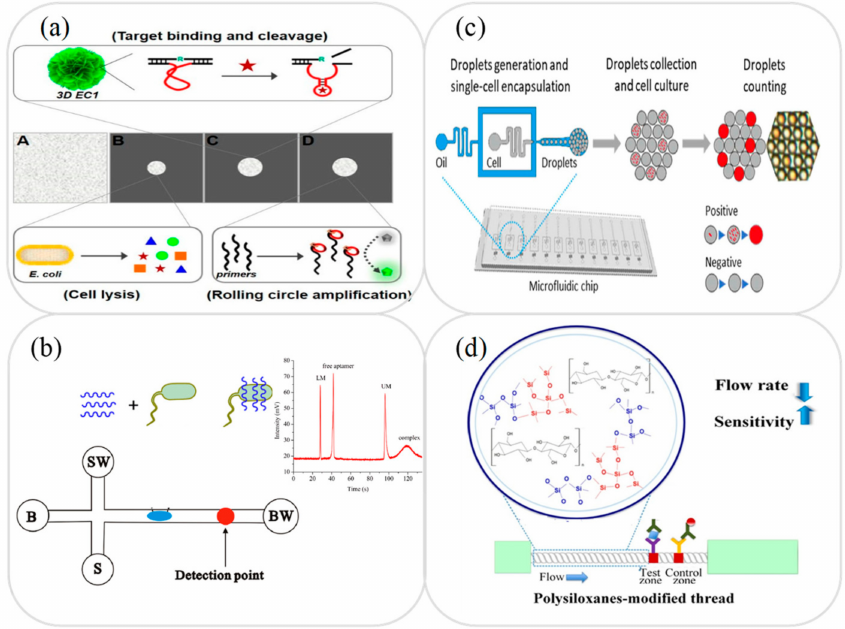
Figure 4. ( a ) Folded microfluidic RCA amplification device for E. coli detection. Reprinted